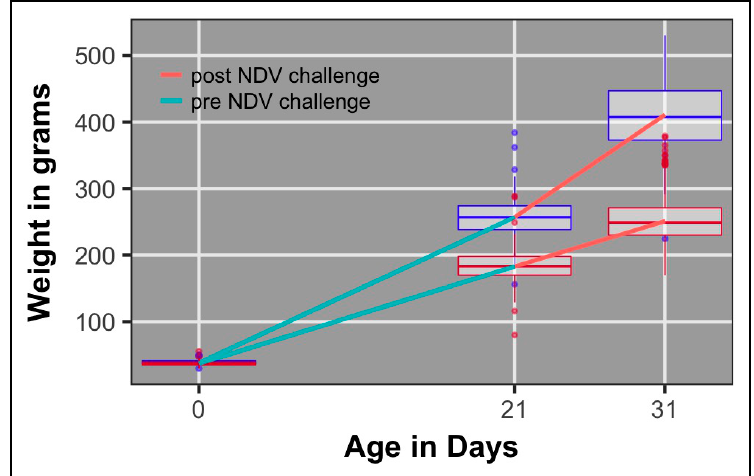
Figure 4. Body weights on days 0, 21, and 31 and regression lines for population average growth rate pre- and post-NDV challenge by treatment group. Red boxes indicate the heat + NDV treatment group, blue boxes indicate the NDV treatment group.